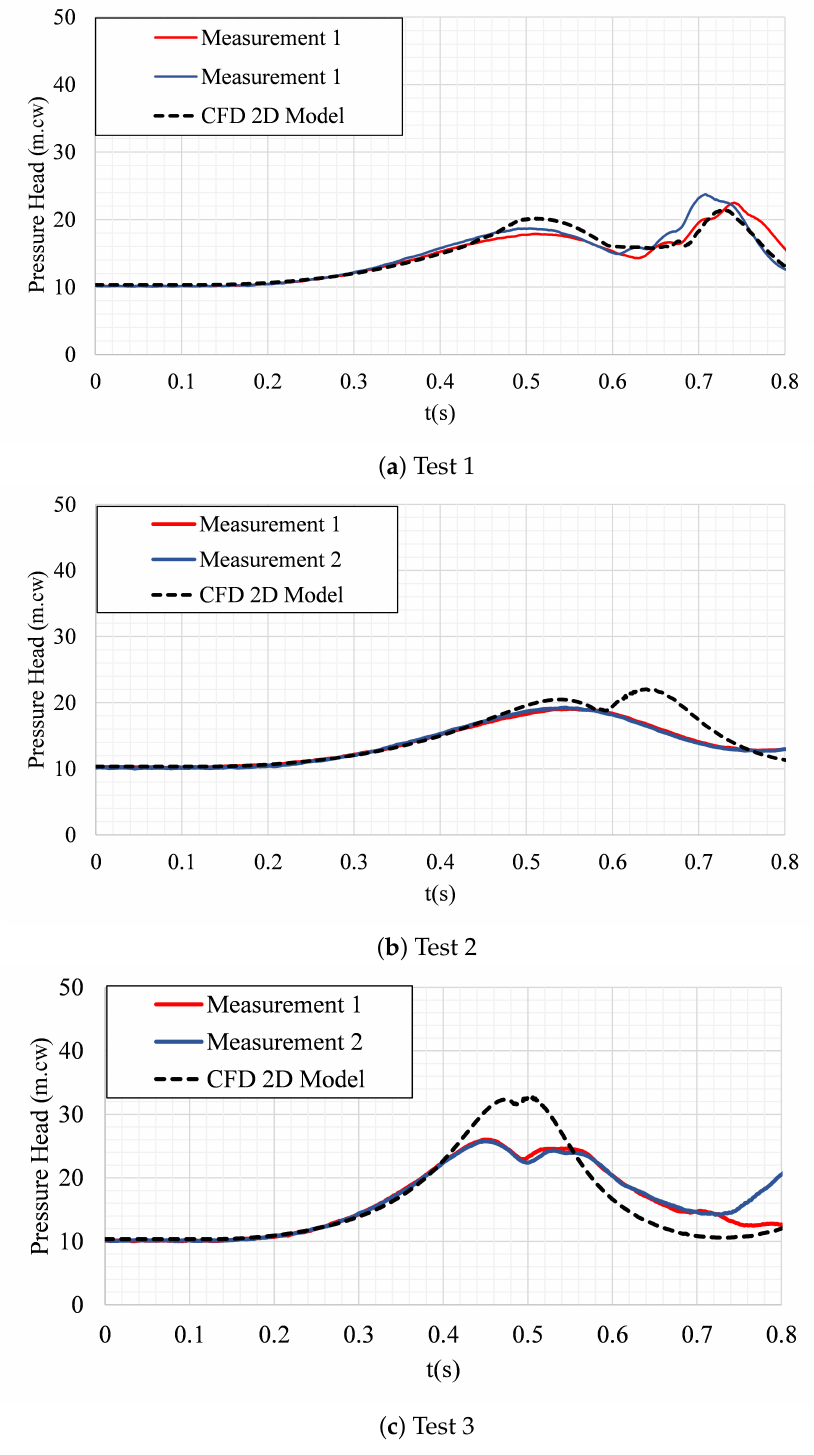
Figure 4. Comparison between measured and computed air pocket pressure